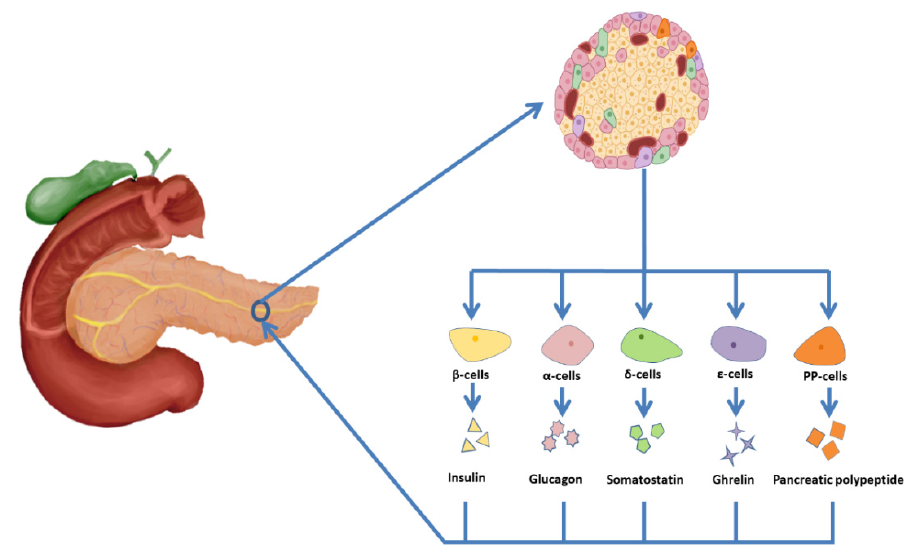
Figure 2. Islet cell composition and secretions. Islet cells are generally divided into β cells (50–60%), which secrete insulin, α cells (30–45%), which secrete glucagon, δ (less than 10%) cells, which secrete somatostatin, PP cells (about 1%), which secrete pancreatic polypeptide, and ε cells (less than 1%), which secrete growth hormone.